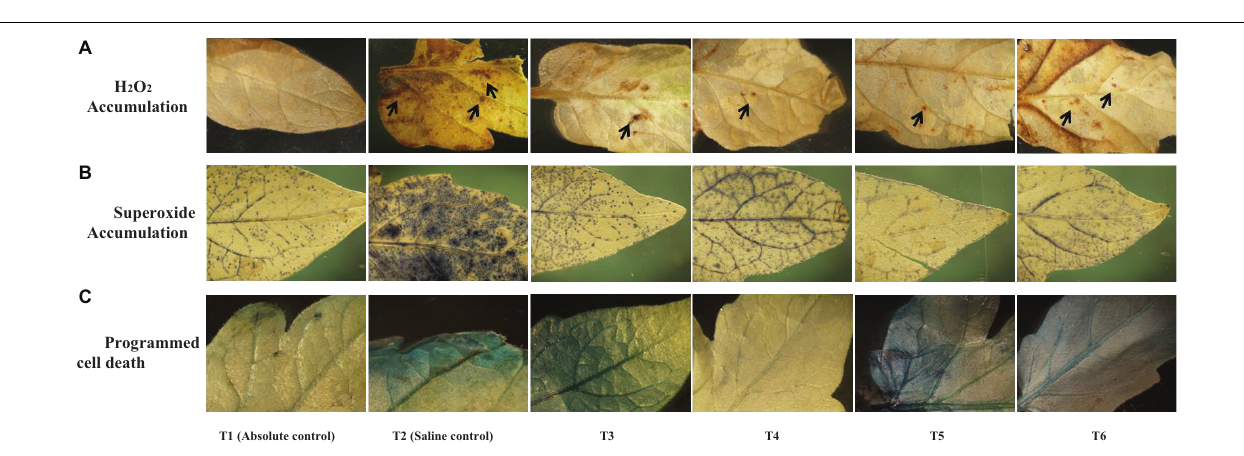
FIGURE 5 | Effect of bacterial endophytes on (A) salinity induced sub-cellular H 2 O 2 accumulation by 3,3 (cid:48) -diaminobenzidine, (B) superoxide accumulation by NBT staining, and (C) programmed cell death by Evan’s blue staining under elevated salinity (150 mM NaCl) as revealed. T1, absolute control; T2, saline control; T3, BTL5; T4, GTR8; T5, GTR11; and T6,